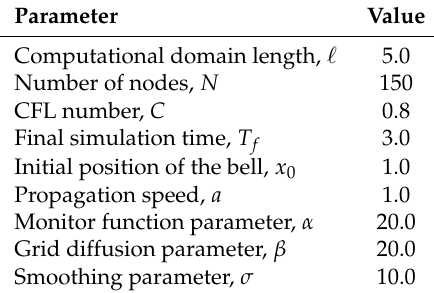
Figure 2. A smooth profile propagation under the linear advection of Equation (1): ( a ) A comparison of different profiles (The thin solid line is the exact solution, (1) is the numerical solution on the uniform mesh, and (2) is the solution on the moving mesh); ( b ) the trajectories of grid nodes in space–time. Note that Figure 2a shows only a zoom of the computational domain. Table 2. The numerical parameters used to simulate the bell-shaped profile propagation under the linear advection of Equation